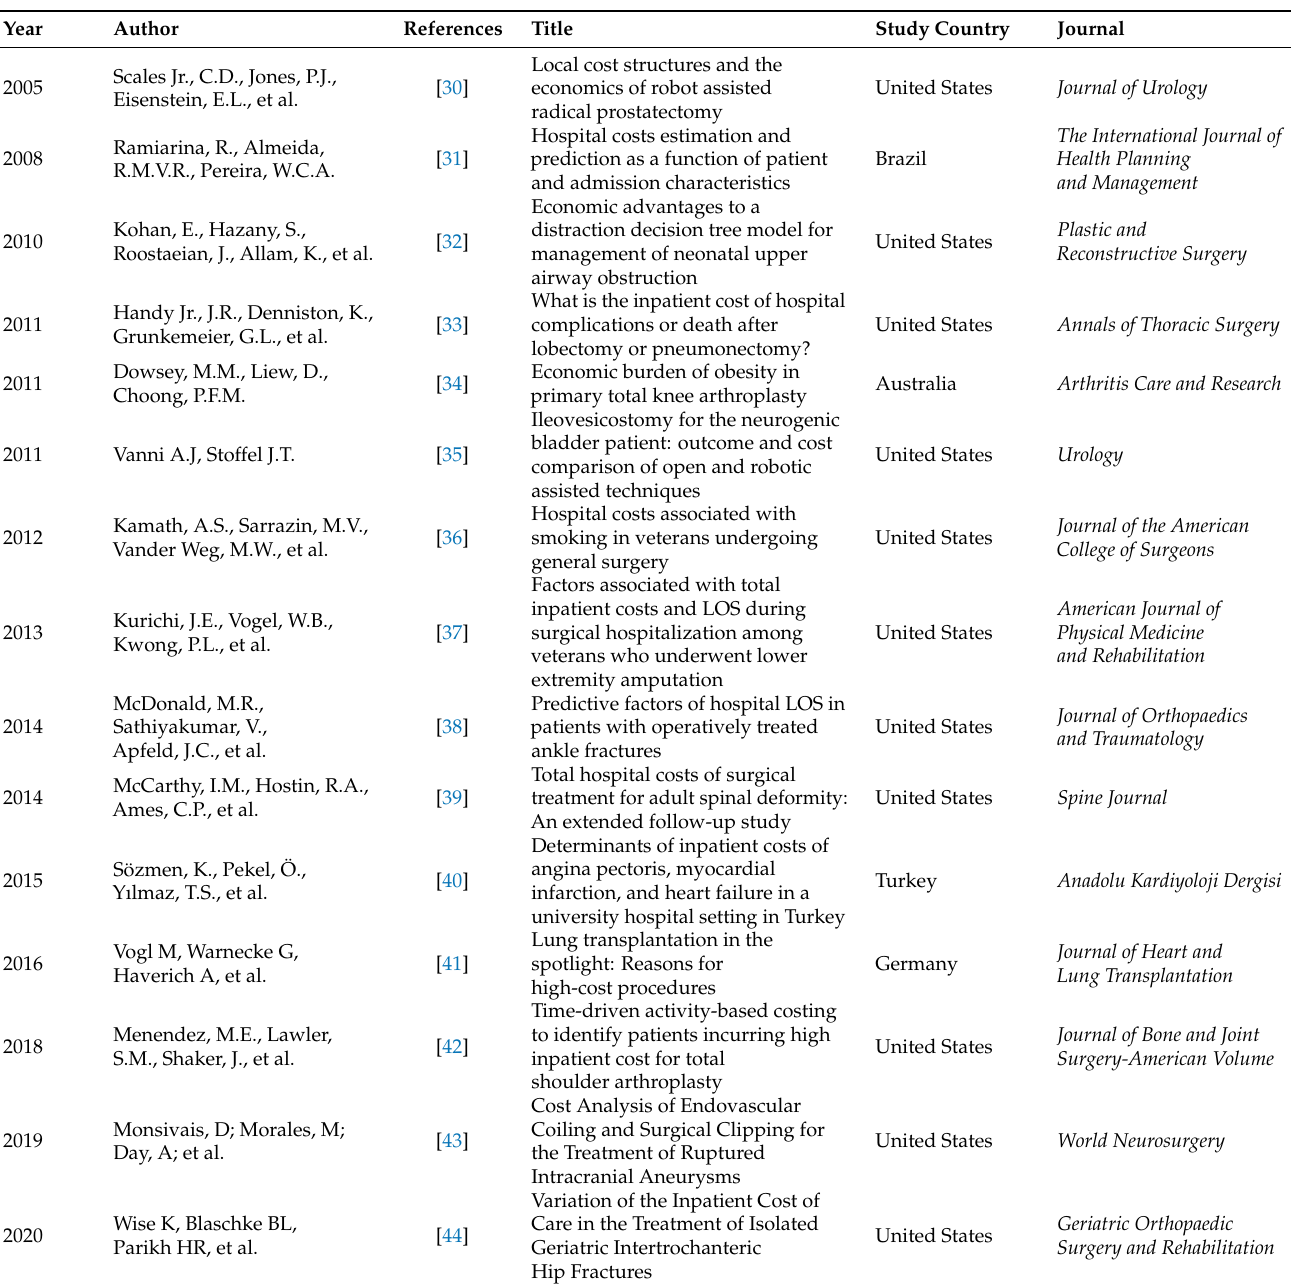
Table 2. Bibliometric